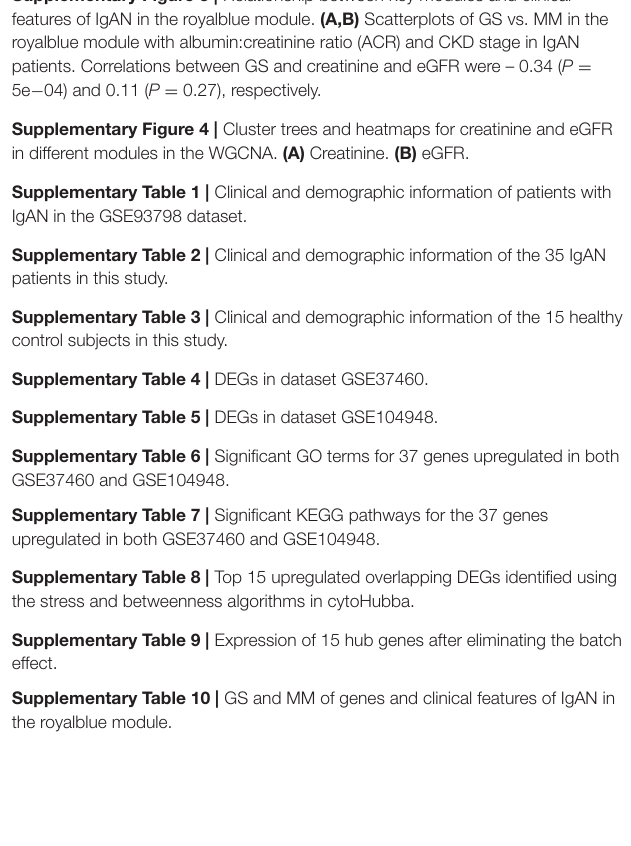
Supplementary Table 9 | Expression of 15 hub genes after eliminating the batch effect. Supplementary Table 10 | GS and MM of genes and clinical features of IgAN in the royalblue